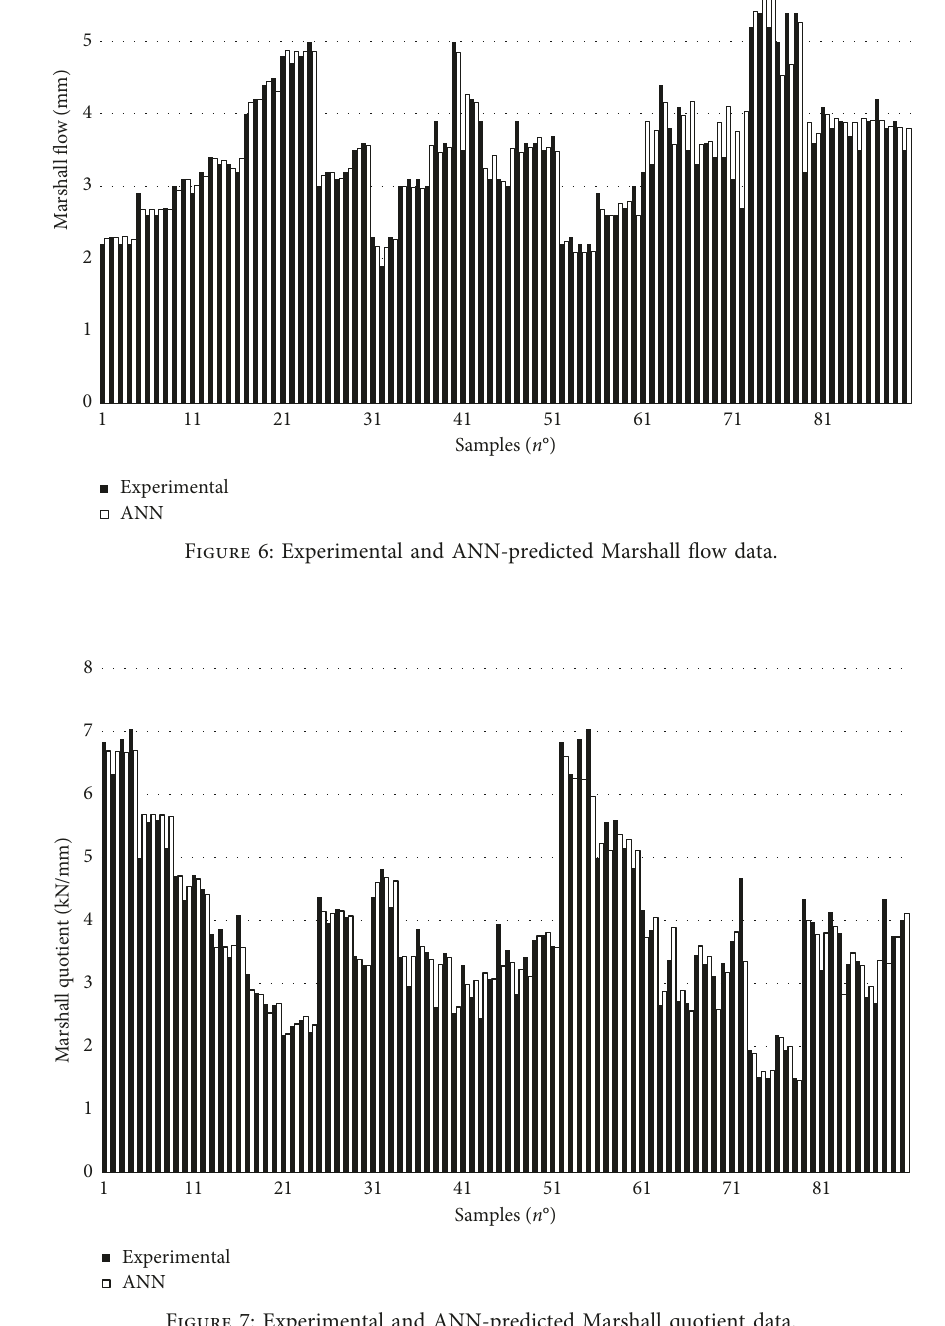
Figure 7: Experimental and ANN-predicted Marshall quotient